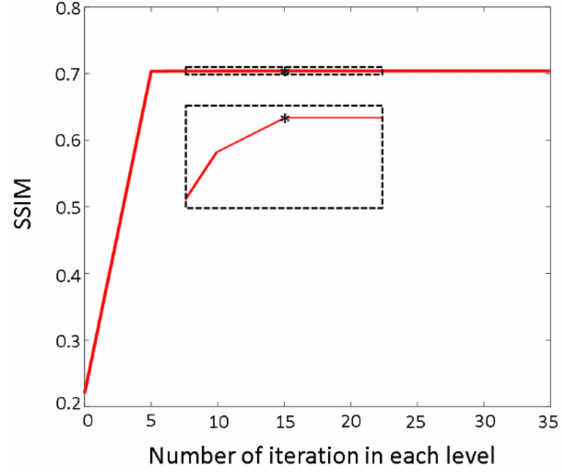
Figure 2. The SSIM for a different number of iterations in each multiscale level in phantom experiment. The inset is an enlarged view of the dashed box region. ”*” labels the best SSIM (0.7039) when 15 iterations.